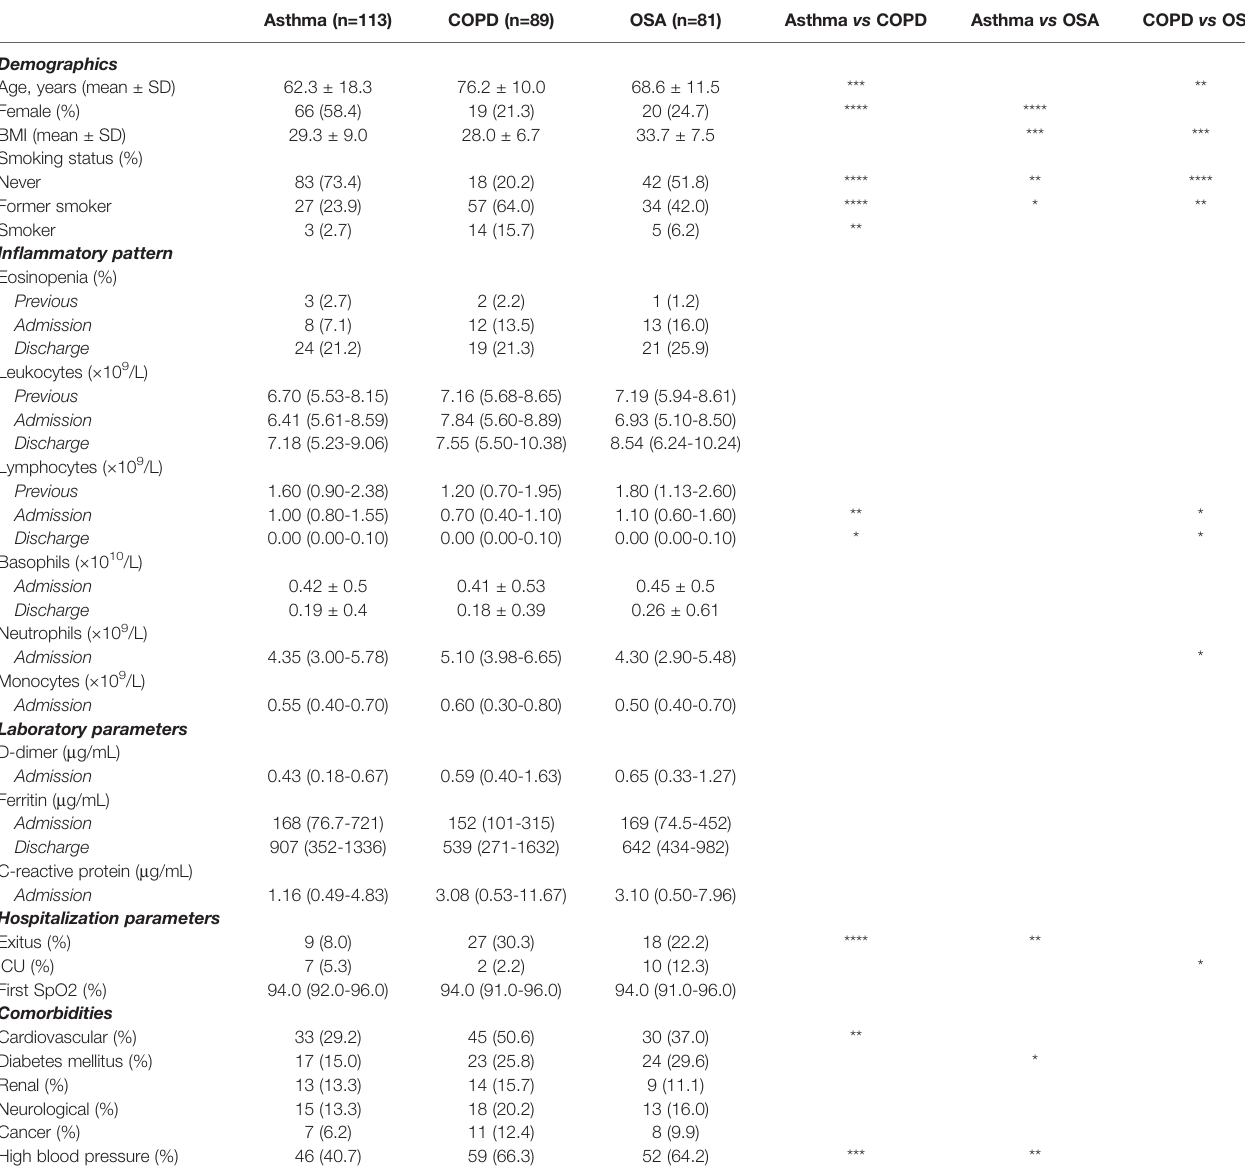
TABLE 2 | Demographic and clinical data of patients with asthma, COPD and